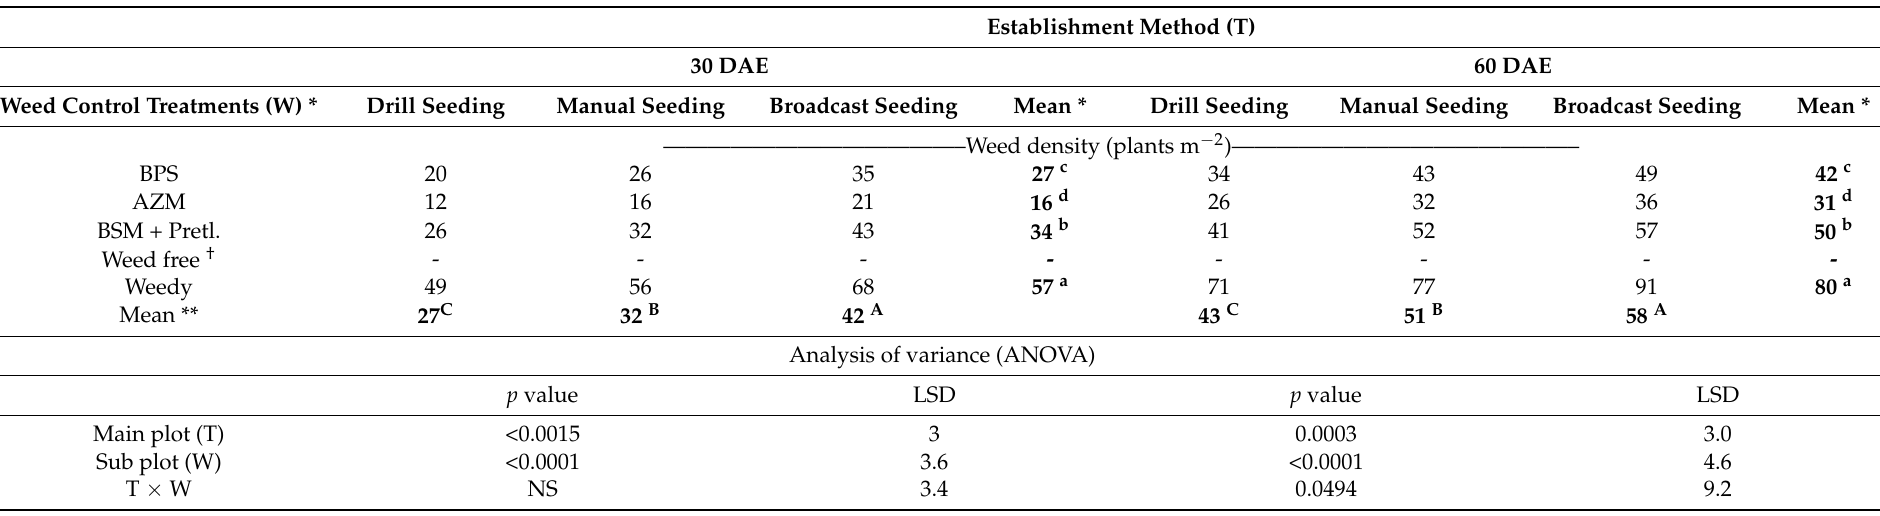
Table 2. Effect of establishment methods and weed control treatments on weed density (plants m − 2 ) at 30 and 60 days after emergence (DAE) at Cuttack, Odisha (Average of 2015 and 2016) §